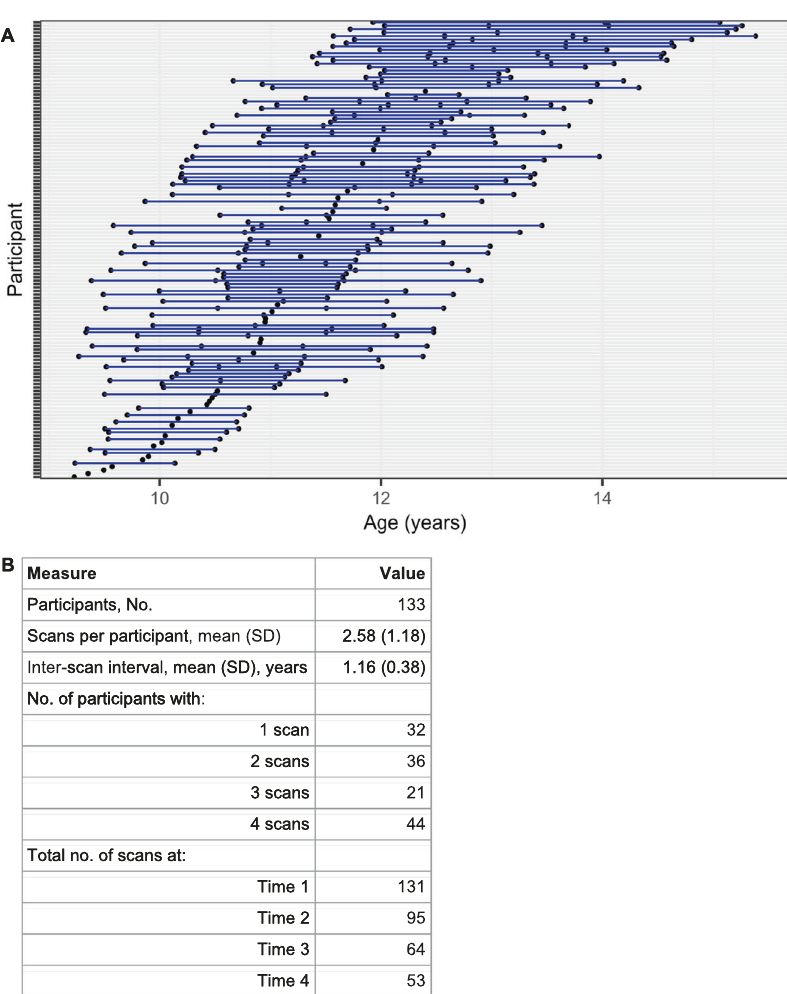
Fig. 1 Depiction of the longitudinal study design. A Each blue line represents one participant; each point represents a scan for the respective participant and indicates age at scan. B Table with descriptive longitudinal scanning